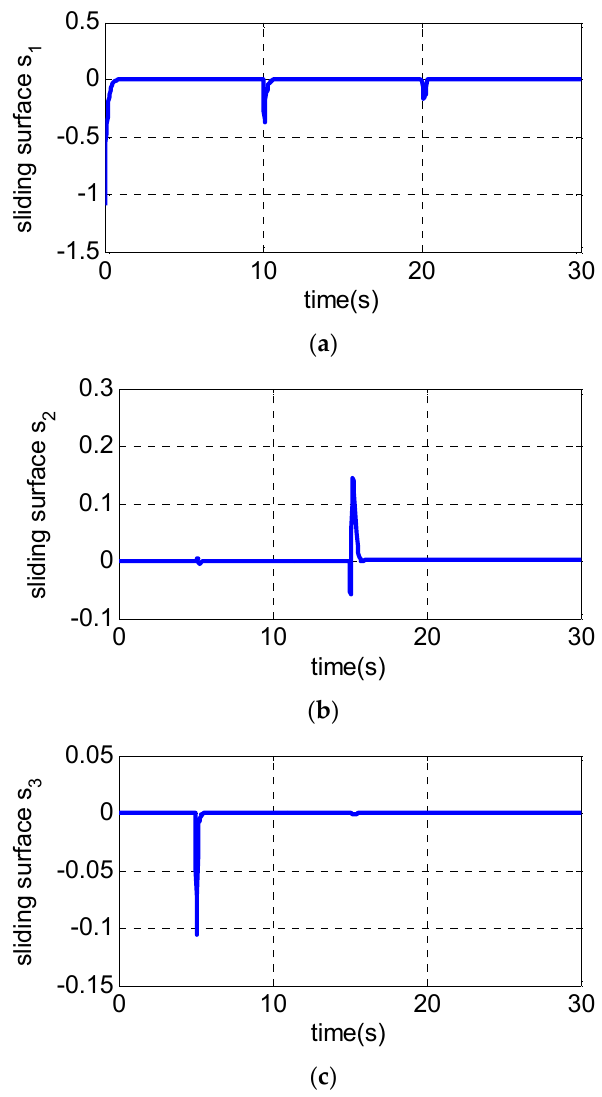
Figure 6. Simulation results of sliding surface of three channels: ( a ) s 1 ; ( b ) s 2 and ( c ) s 3 .